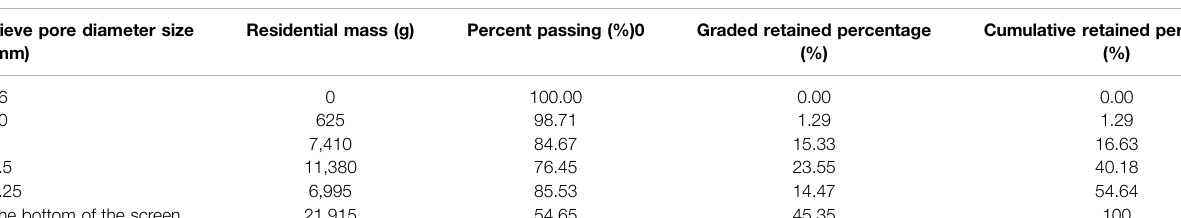
TABLE 2 | Gradation parameters of crushed gangue. Sieve pore diameter size (mm)